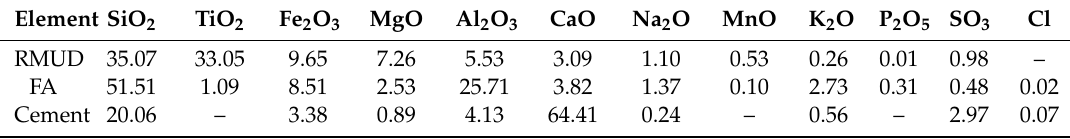
Table 1. Concentration (%) of main constituents in RMUD, FA, and cement